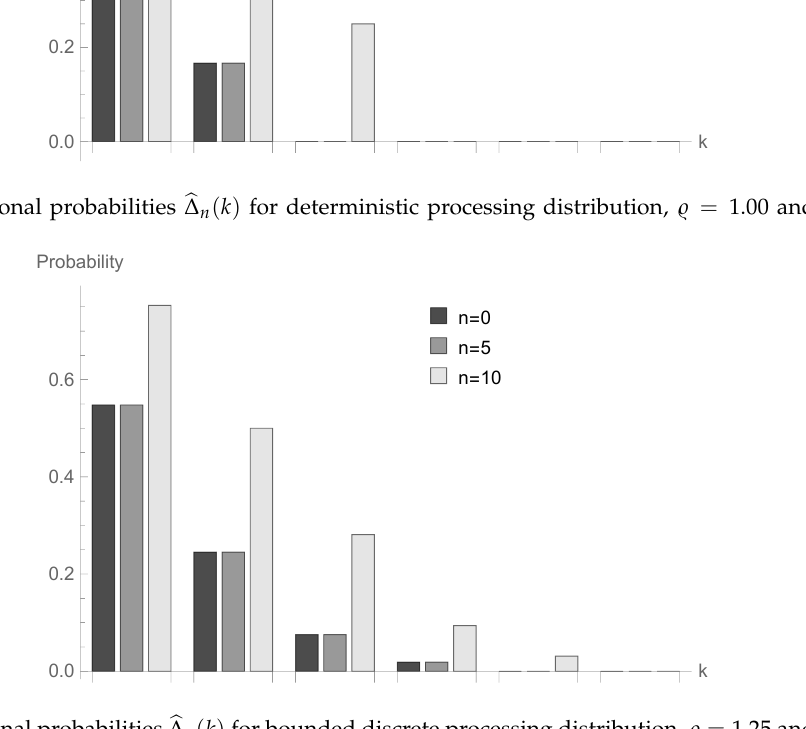
Figure 6. Conditional probabilities (cid:98) ∆ n ( k ) for bounded discrete processing distribution, (cid:36) = 1.25 and n = 0,5 and